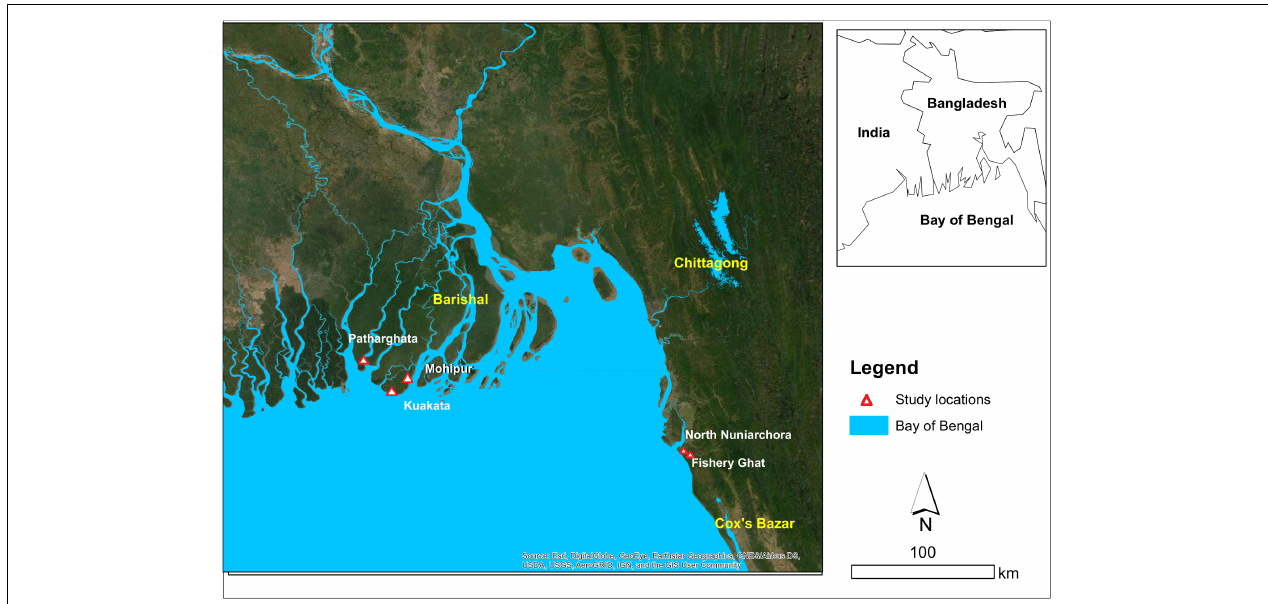
FIGURE 1 | Location of the study